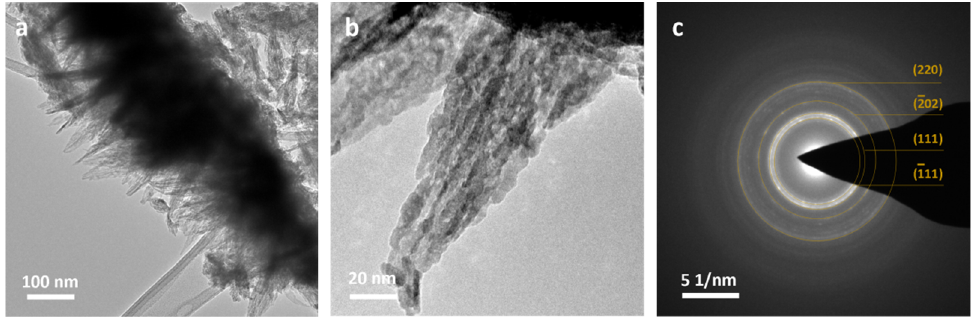
(Figure 6a,b). The SAED pattern consisted of characteristic rings for copper(II) oxide (111), (111), (202) and (220) and planes, without any spots for Cu(OH) 2 (Figure 6c).